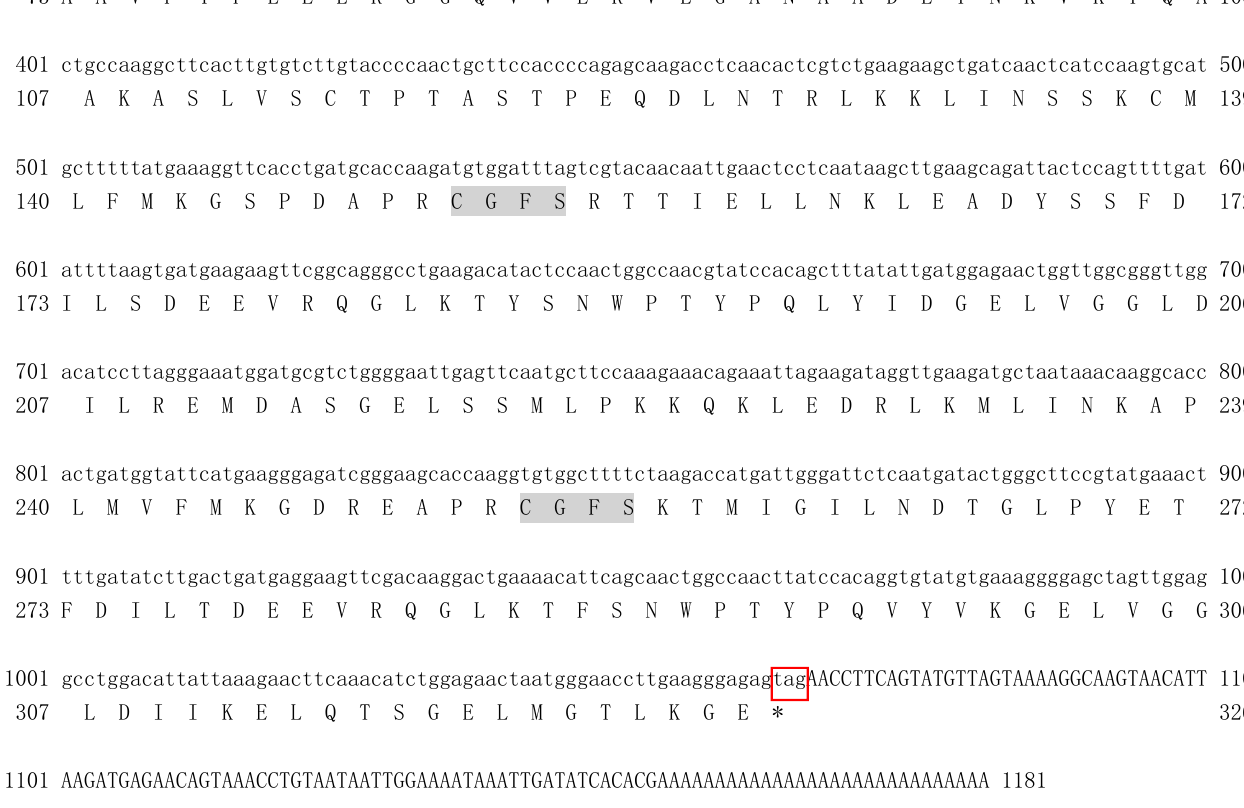
Figure 1. Nucleotide and deduced amino acid sequences of SpGrx3 . The letters in the red box indicated the start codon (atg) and stop codon (tga). The shading indicates the catalytic amino acids (C-G-F-S).